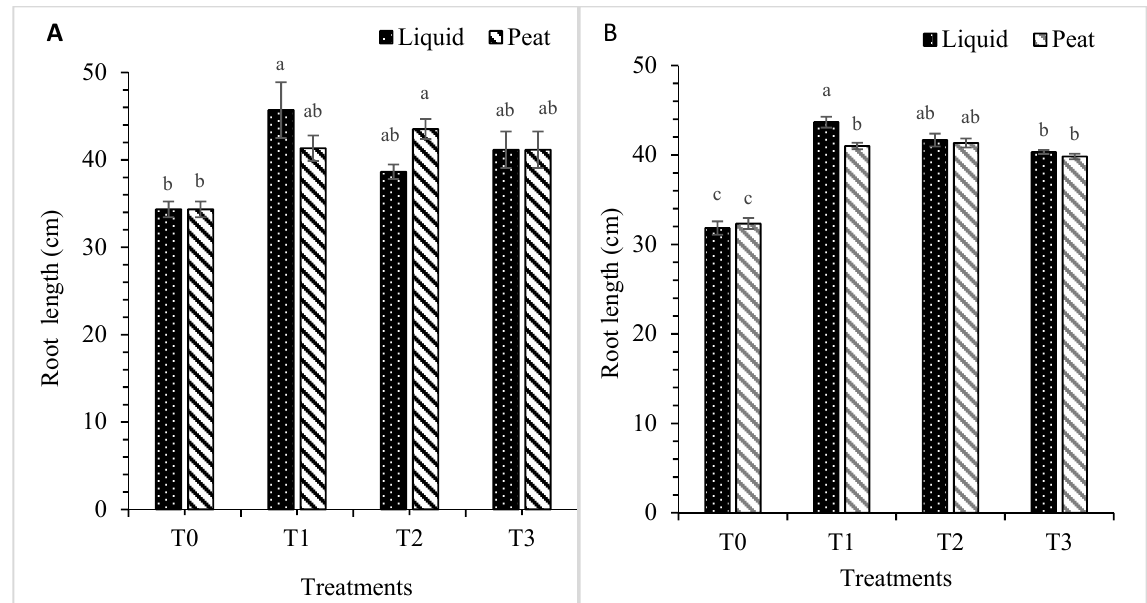
Figure 3. Root length subjected to liquid formulation (T0 = 0 mL, T1 = 150 mL, T2 = 300 mL and T3 = 150 mL) and peat formulation of Bradyrhizobium japonicum (T0 = 0 mg, T1 = 250 mg, T2 = 500 mg and 150 mL) in bioclimatic zone (( A ) = Bronkhorspruit/Gauteng) and (( B ) = Hartbeesfoein/North West province). Bars sharing a letter are not significantly different (Lsd zone A) = 8.063 and (Lsd zone B) = 2.541. Data are means ± standard errors.